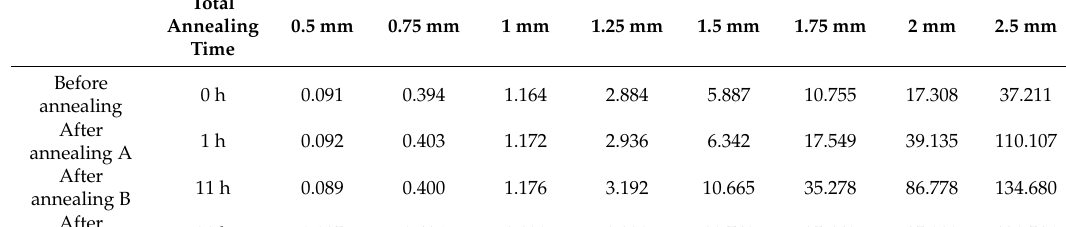
Table 5. The averaged maximum deflections (µm) with respect to the diaphragm radius at 900 °C.